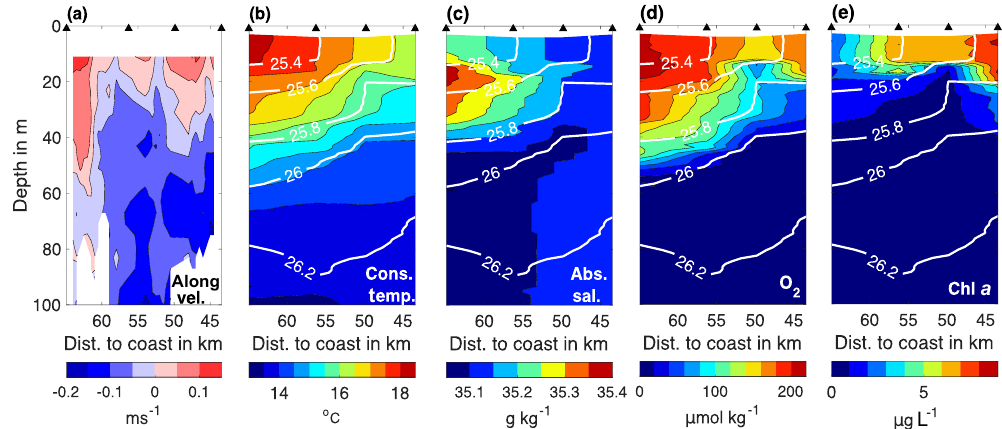
Figure 5. CTD transect across the upwelling front before the main experiment conducted on 16 February 2013. Measured quantities contain along-frontal current velocities (a) , conservative temperature (b) , absolute salinity (c) , O 2 (d) , and Chl a concentrations (e) . Isopycnals are given by white lines in (b) – (e) . Around CTD stations the along-frontal velocity is horizontally linearly